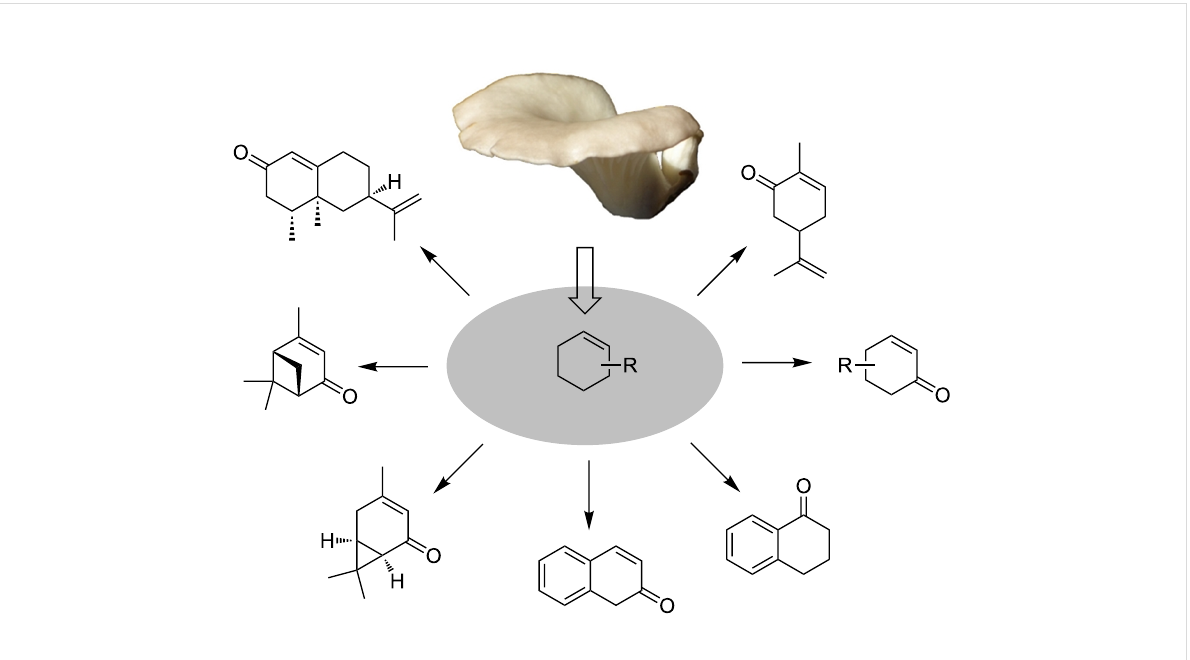
Figure 1: Selected biocatalytic allylic and benzylic oxidations with the lyophilisate of Pleurotus sapidus